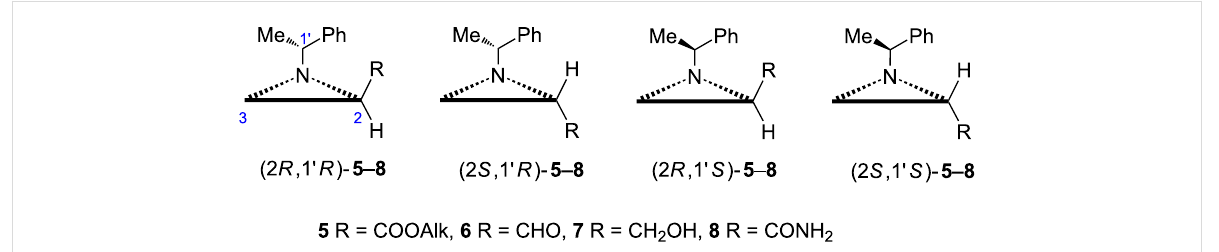
Figure 2: Structures of derivatives of N -(1-phenylethyl)aziridine-2-carboxylic acid 5 – 8 .